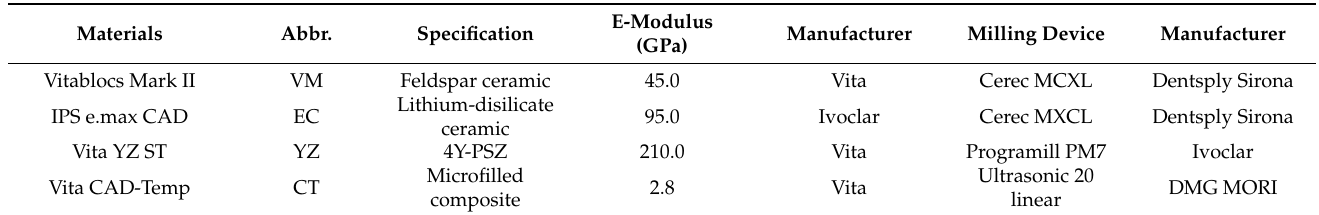
Table 1. Restorative materials and corresponding milling devices used. Elastic modulus according to manufacturer.